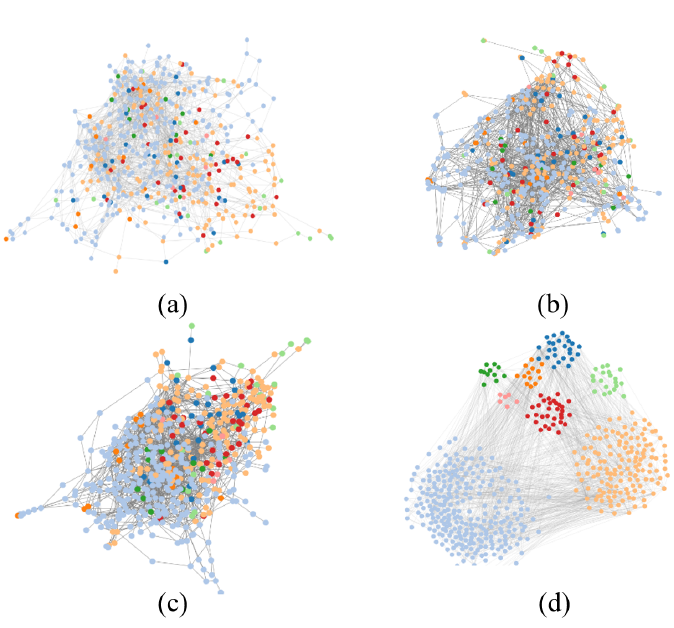
Figure 5. The result of attribute community layout under the attribute ‘Journal’. ( a ) FR